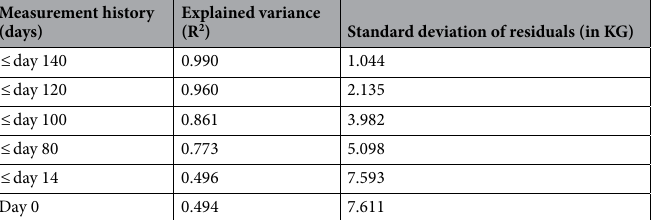
Measurement history